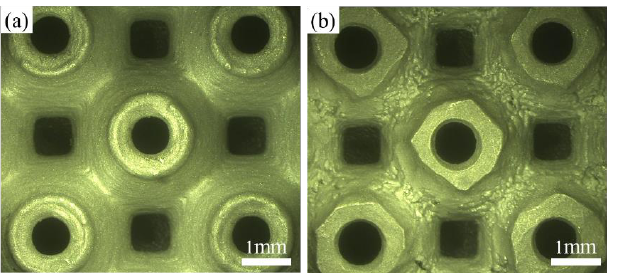
Figure 6. Structure surface under the optical microscope: ( a ) Top of as-built P-TPMS; ( b ) bottom of